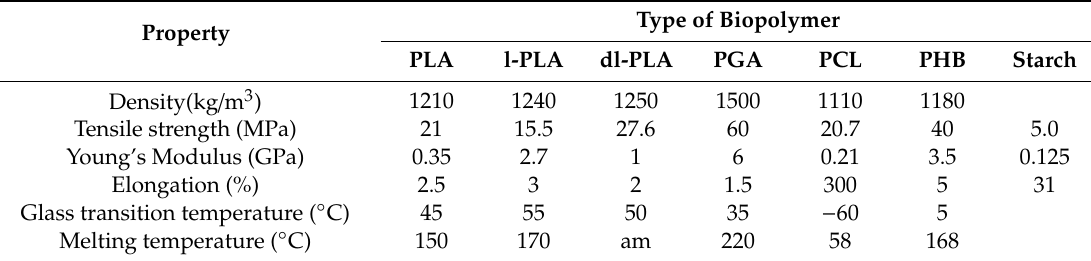
Table 1. Physical properties of different types of biopolymers [18] .